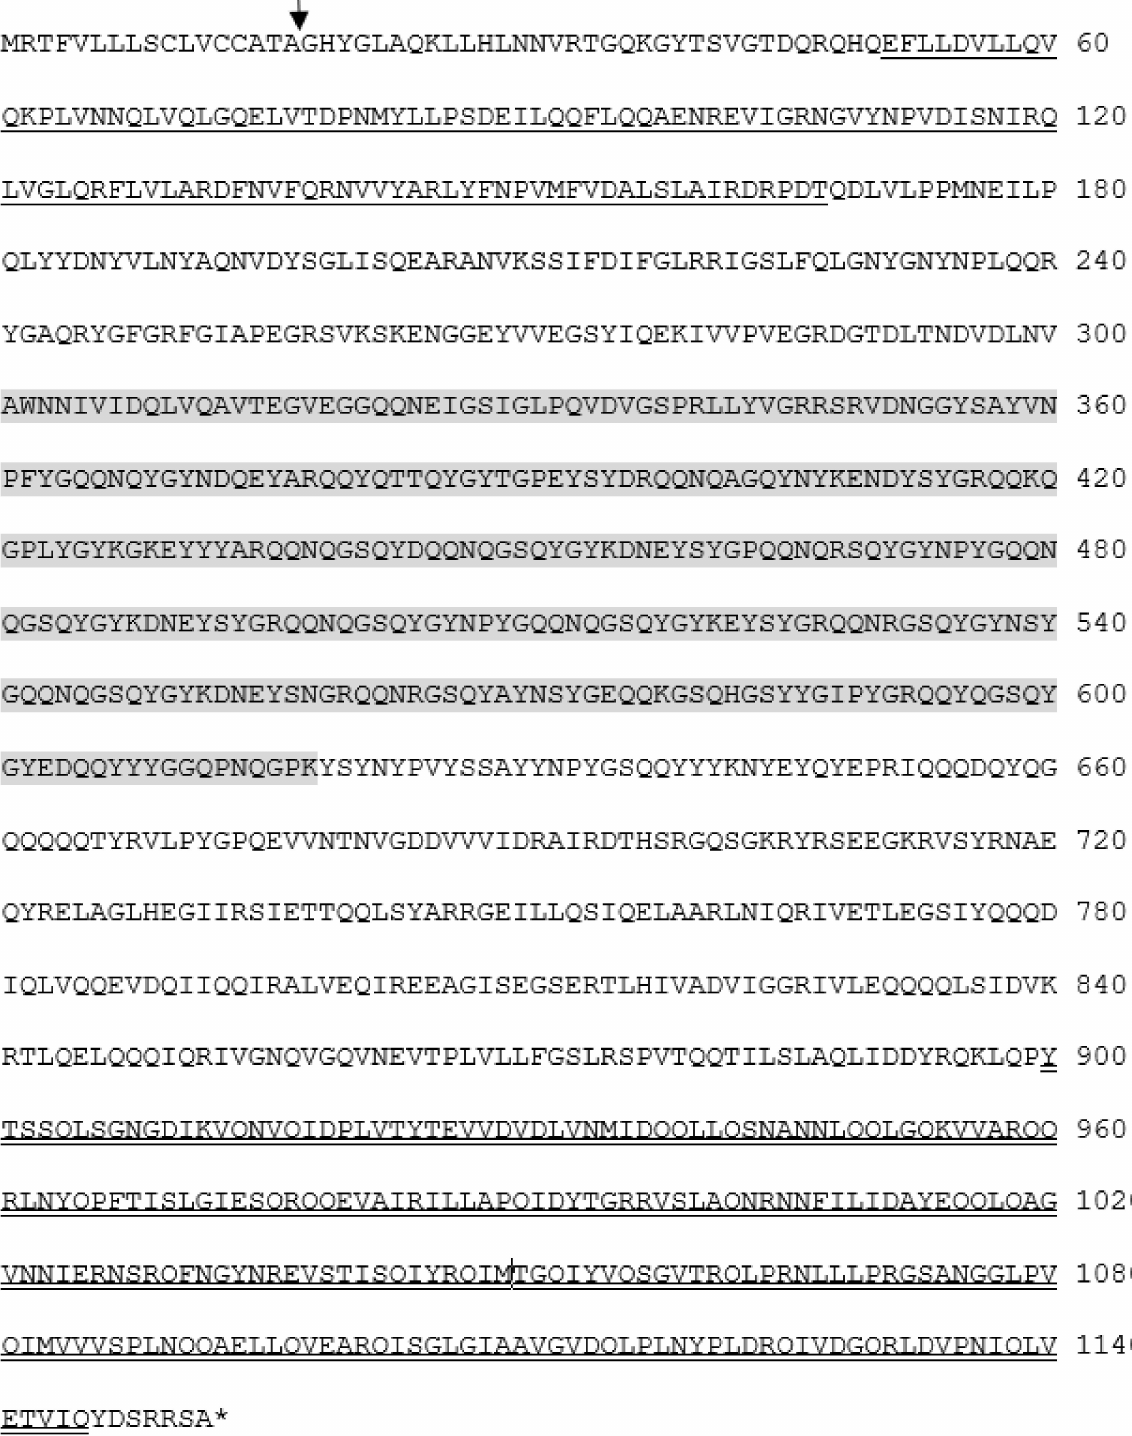
Figure 2. Deduced amino acid sequences of the fat body protein 1 cDNA from B. dorsalis (GenBank accession number MT514270). The cleavage site of the putative signal peptide sequence is indicated by a vertical arrow. The hemocyanin N domain is underlined, the hemocyanin C domain is indicated with double underlines, and the high molecular weight glutenin subunit is marked in